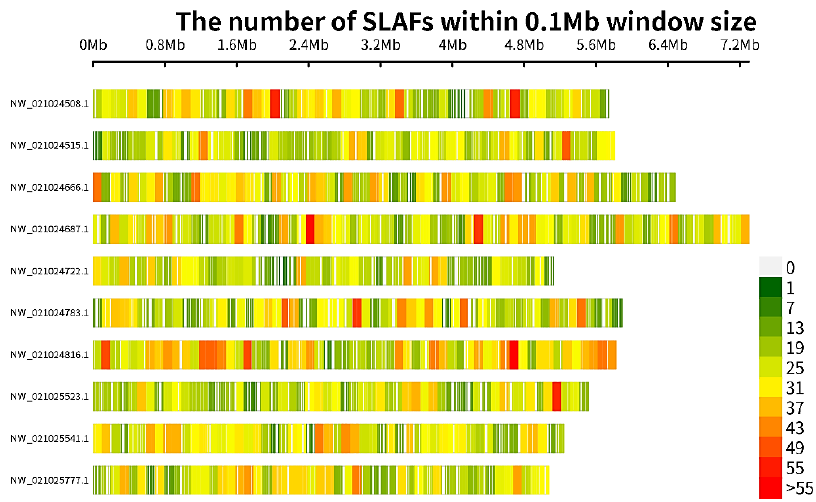
Figure 2. Distribution of SLAF tags on the chromosomes. The abscissa is the length of the chromo- somes, and each band represents a chromosome. The genome is divided according to the size of 0.1MB. The more SLAF tags in each window, the darker the color. Fewer SLAF tags are indicated in a lighter color. The darker area is the area where SLAF tags are concentrated.